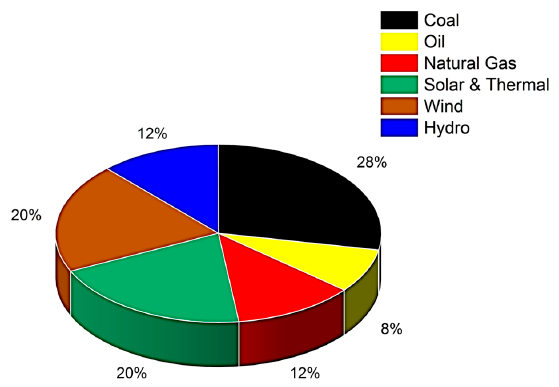
Figure 3. Moroccan Electricity Production Mix.